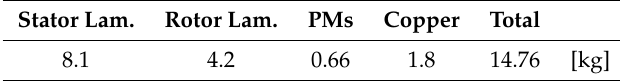
Table 4. Weight of active materials for the prototype machine. Stator Lam. Rotor